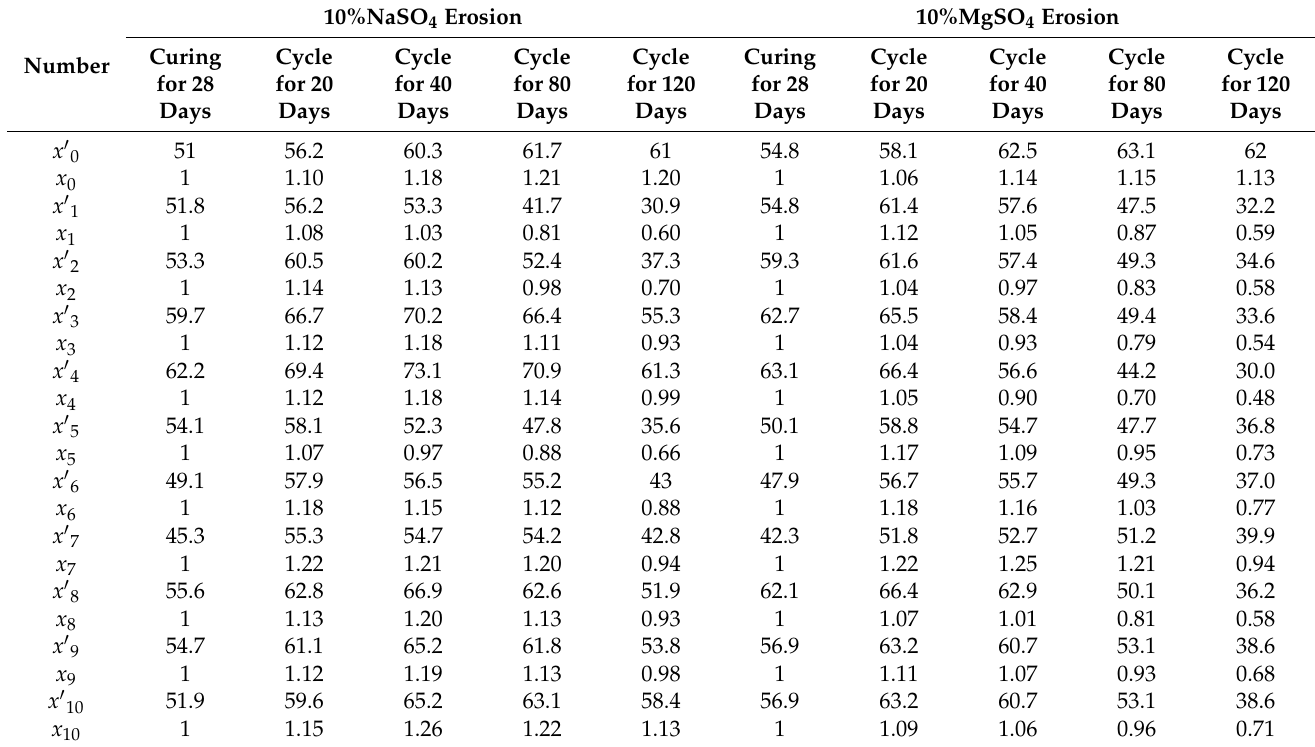
Table 3. Original test data and dimension elimination data of concrete under erosion.